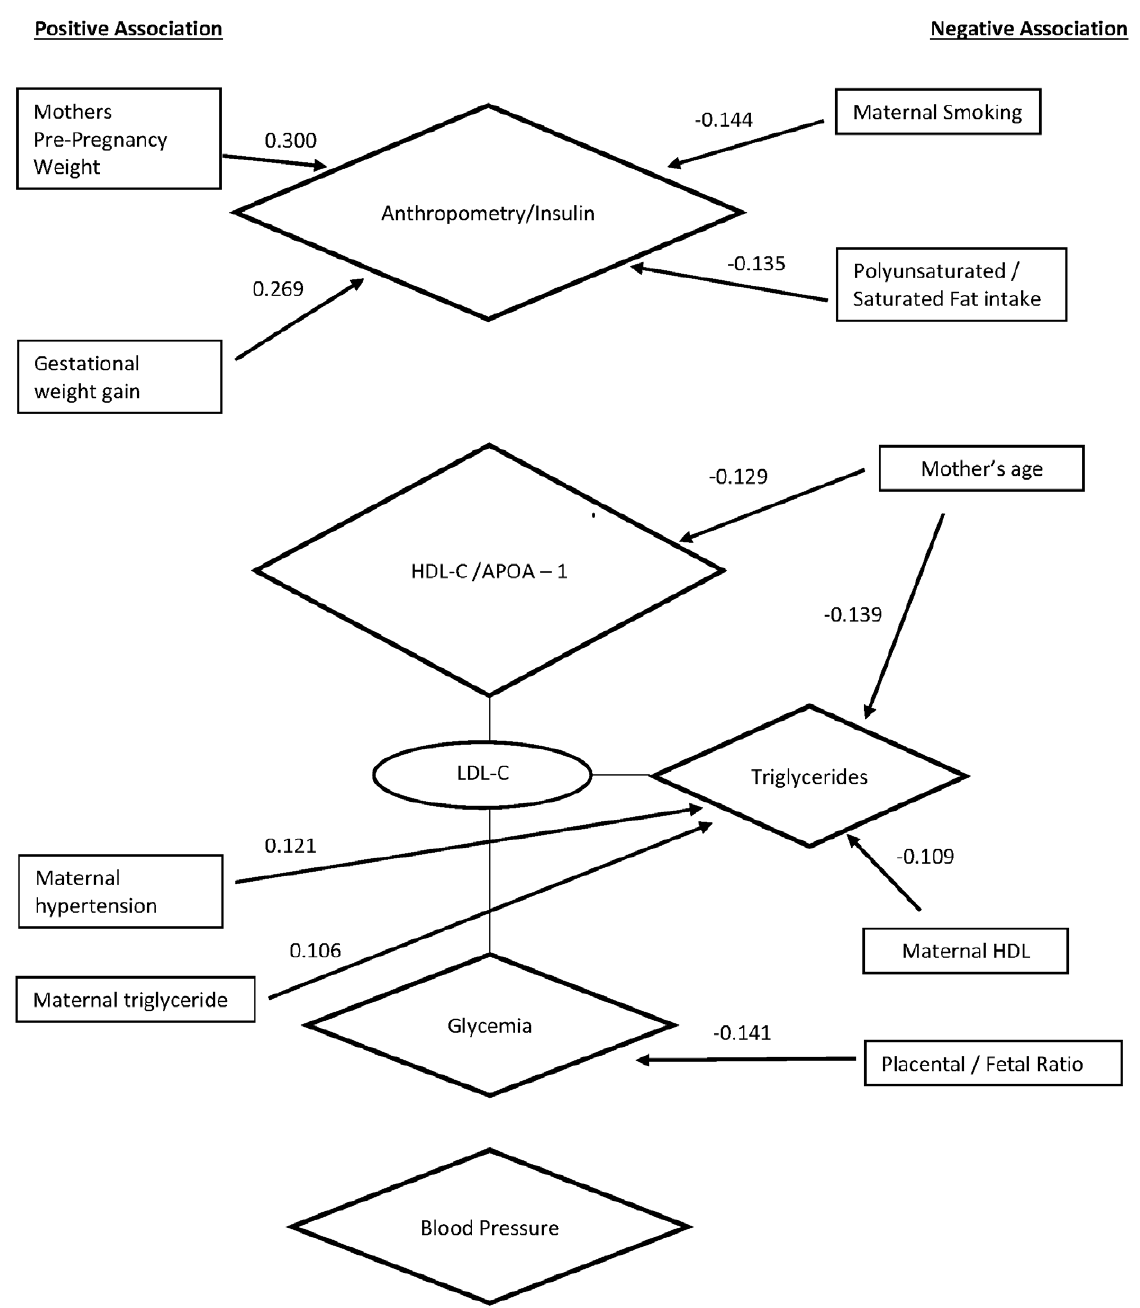
Figure 1. Visual representation of the relationship between newborn cardiometabolic components (illustrated with diamonds) and the maternal/pregnancy variables associated with them (in rectangles). Numbers beside the arrows represents the strength and direction of the relationship between the variable and the component. Variables within ovals ‘‘bridge’’ 2 components as they are loaded onto more than one component. All newborn traits were adjusted for gestational age and sex prior to principal component analysis. Blood pressure and body fat were also adjusted for age at time of measurement.